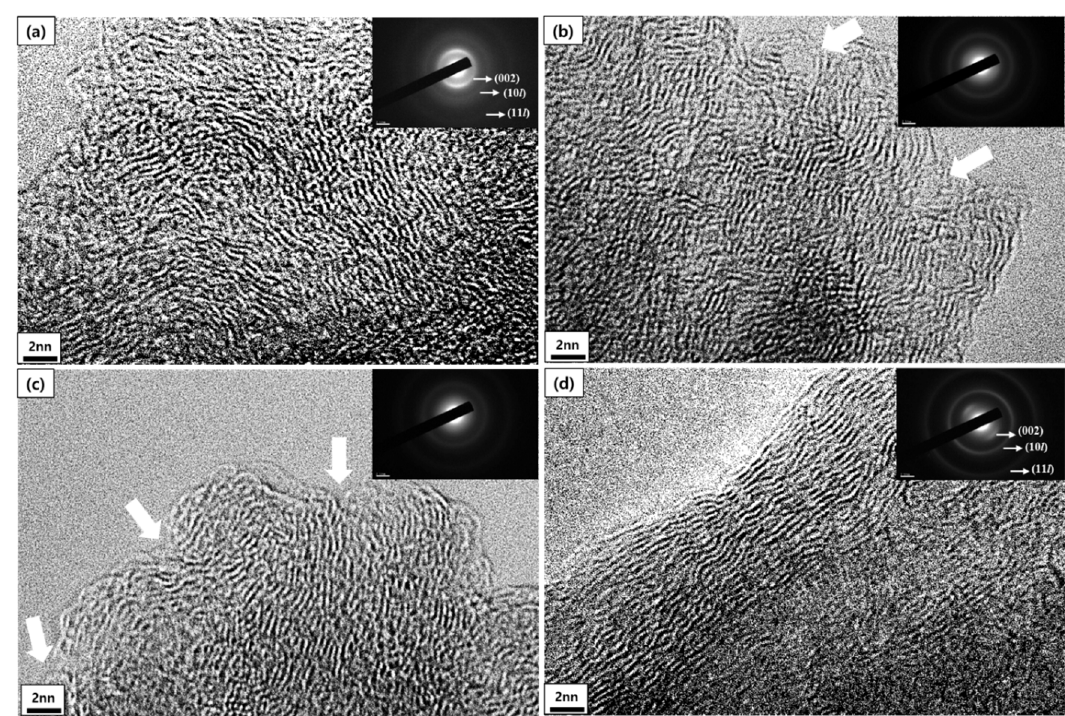
Figure 8. TEM lattice image and diffraction pattern (×800 k) of mPCFs depending on milling time: ( a ) desized carbon fiber; ball milling times of ( b ) 6 h mPCFs, ( c ) 12 h mPCFs, and ( d ) 18 h mPCFs.